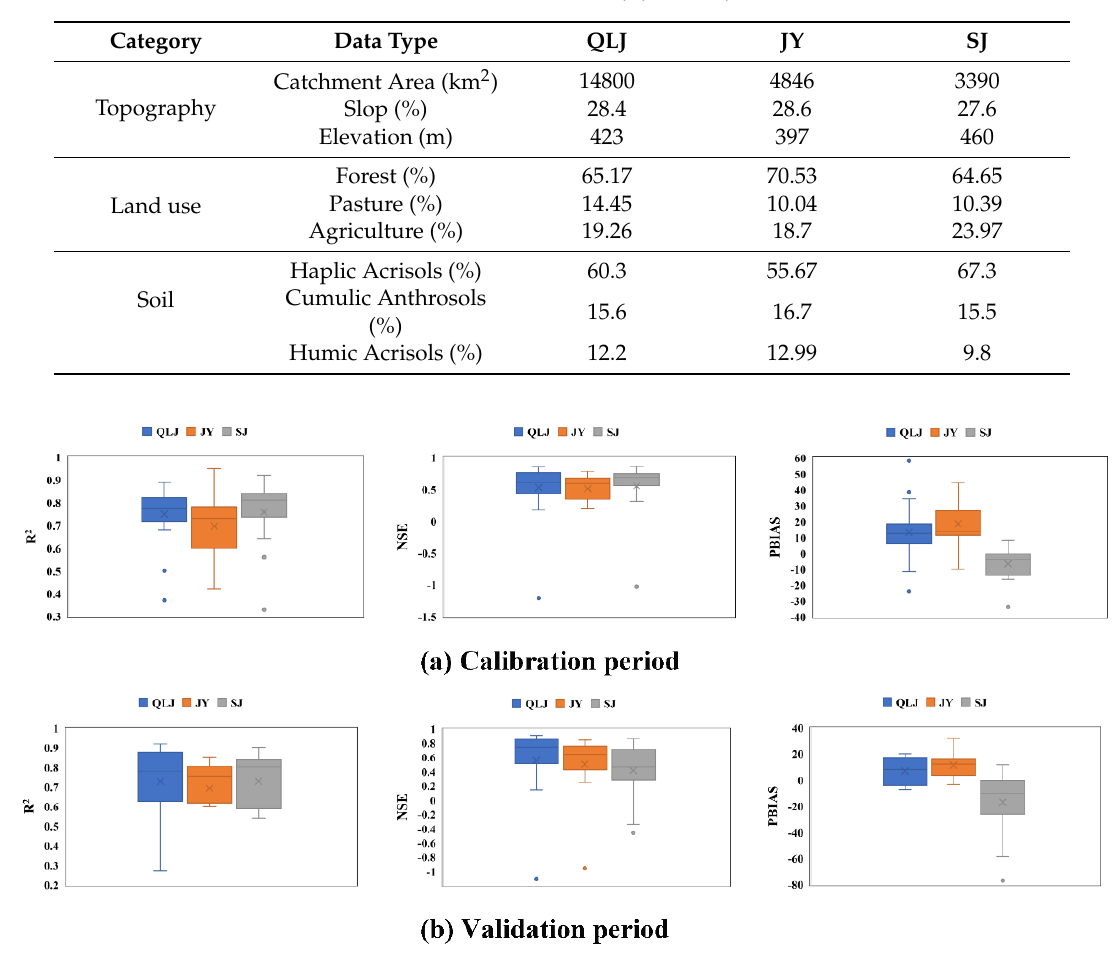
Figure 6. Boxplots of R 2 , NSE and PBIAS. In each boxplot, the whisker ranges from the minimum to maximum, while the box ranges from the first quartile to the third quartile. The symbol cross represents the mean value and the symbol circle dot represents the outlier.